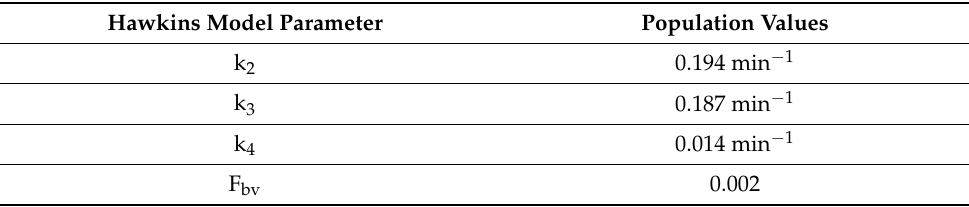
Table 1. Population values of the Hawkins model rate constants in Figure 1A used for the short dynamic scan analyses. The value of K 1 was set using Equation